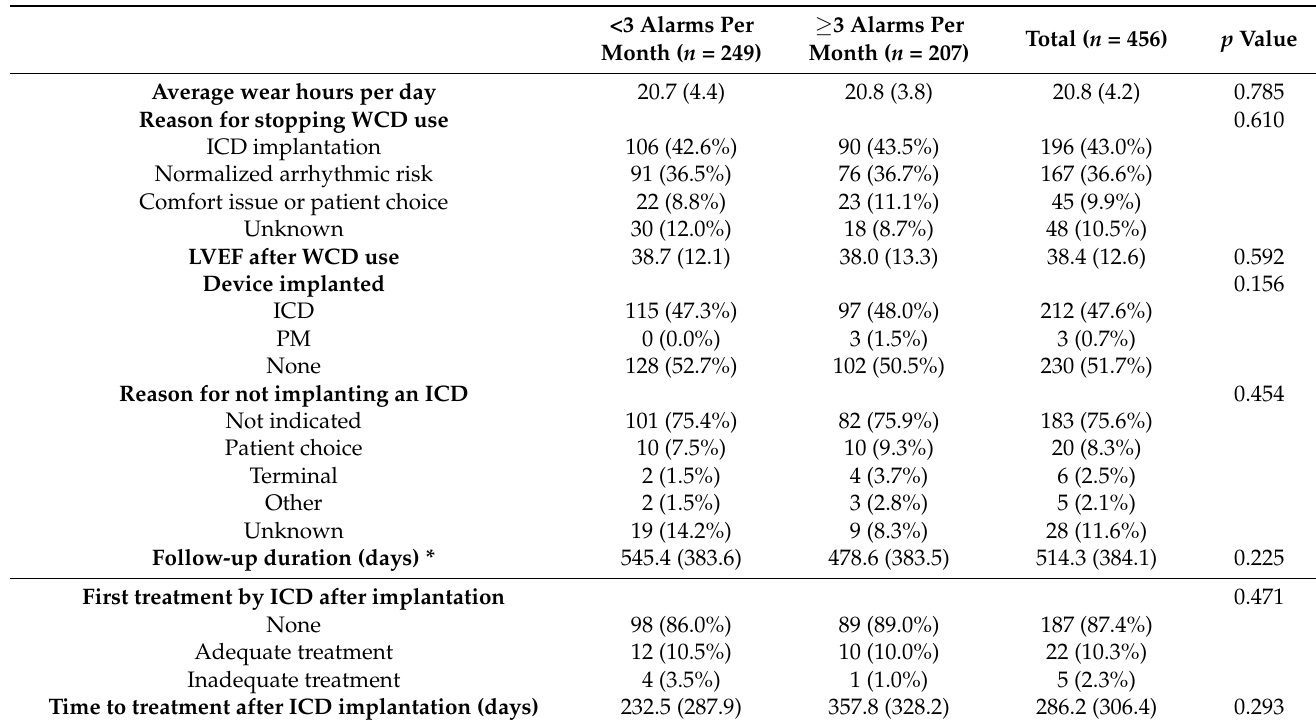
Table 2. WCD wear data and outcomes.